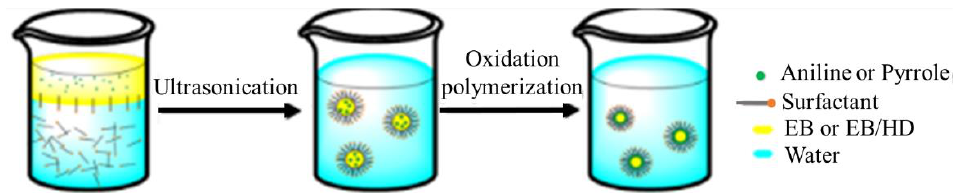
Figure 31. Oxidative polymerization of aniline or pyrrole in miniemulsion to form conductive polymer nanocapsules in the existence of ethylbenzene (EB) or ethylbenzene/hexadecane (EB/HD). Reprinted with permission from Lv, L.-P.; Zhao, Y.; Vilbrandt, N.; Gallei, M.; Vimalanandan, A.; Rohwerder, M.; Landfester, K.; Crespy, D. Redox Responsive Release of Hydrophobic Self-Healing Agents from Polyaniline Capsules. J. Am. Chem. Soc. 2013, 135, 14198–14205, doi:10.1021/ja405279t. American Chemical Society.